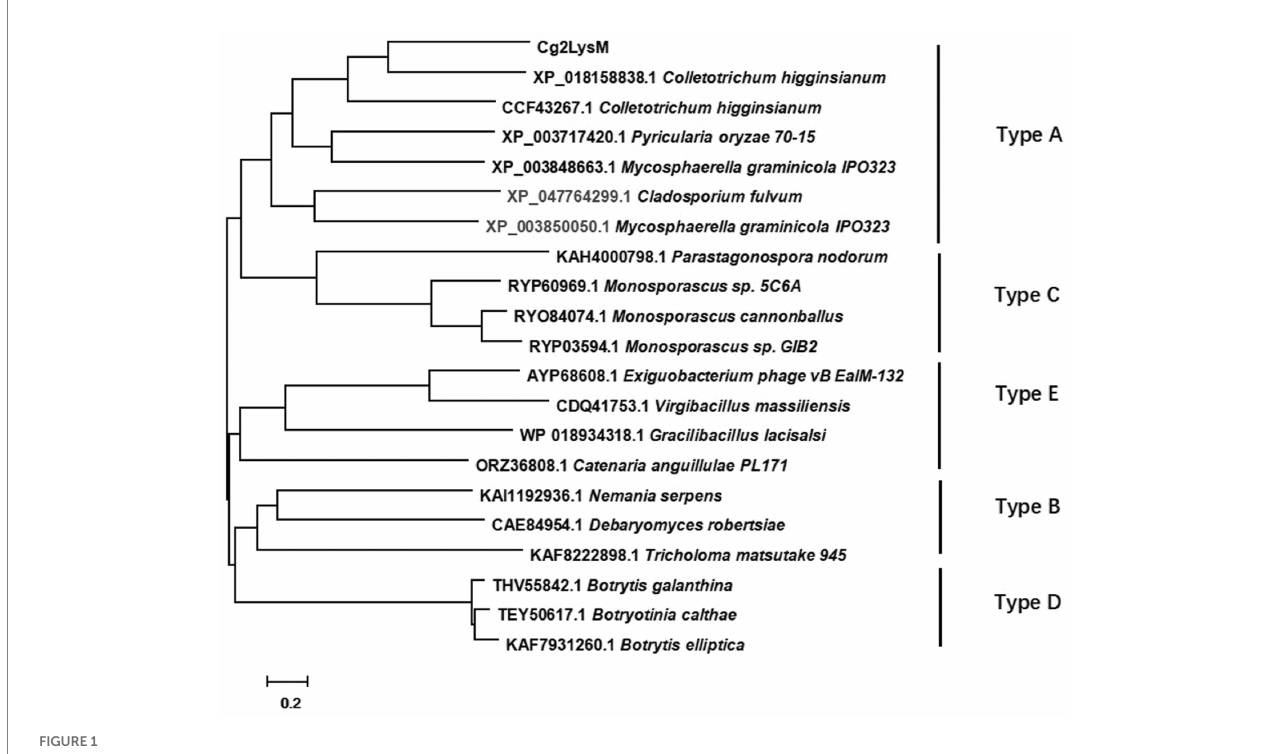
FIGURE 1 Phylogenetic analysis of Cg2LysM with different type of LysM effectors in fungi.